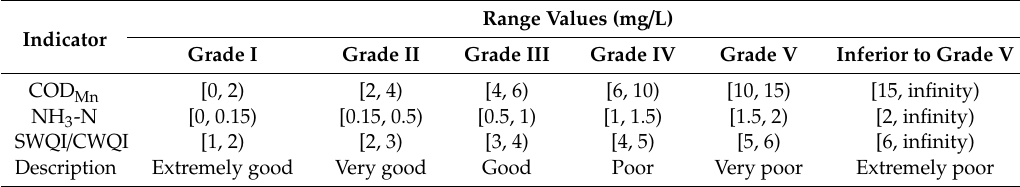
Table 1. The range values of water quality